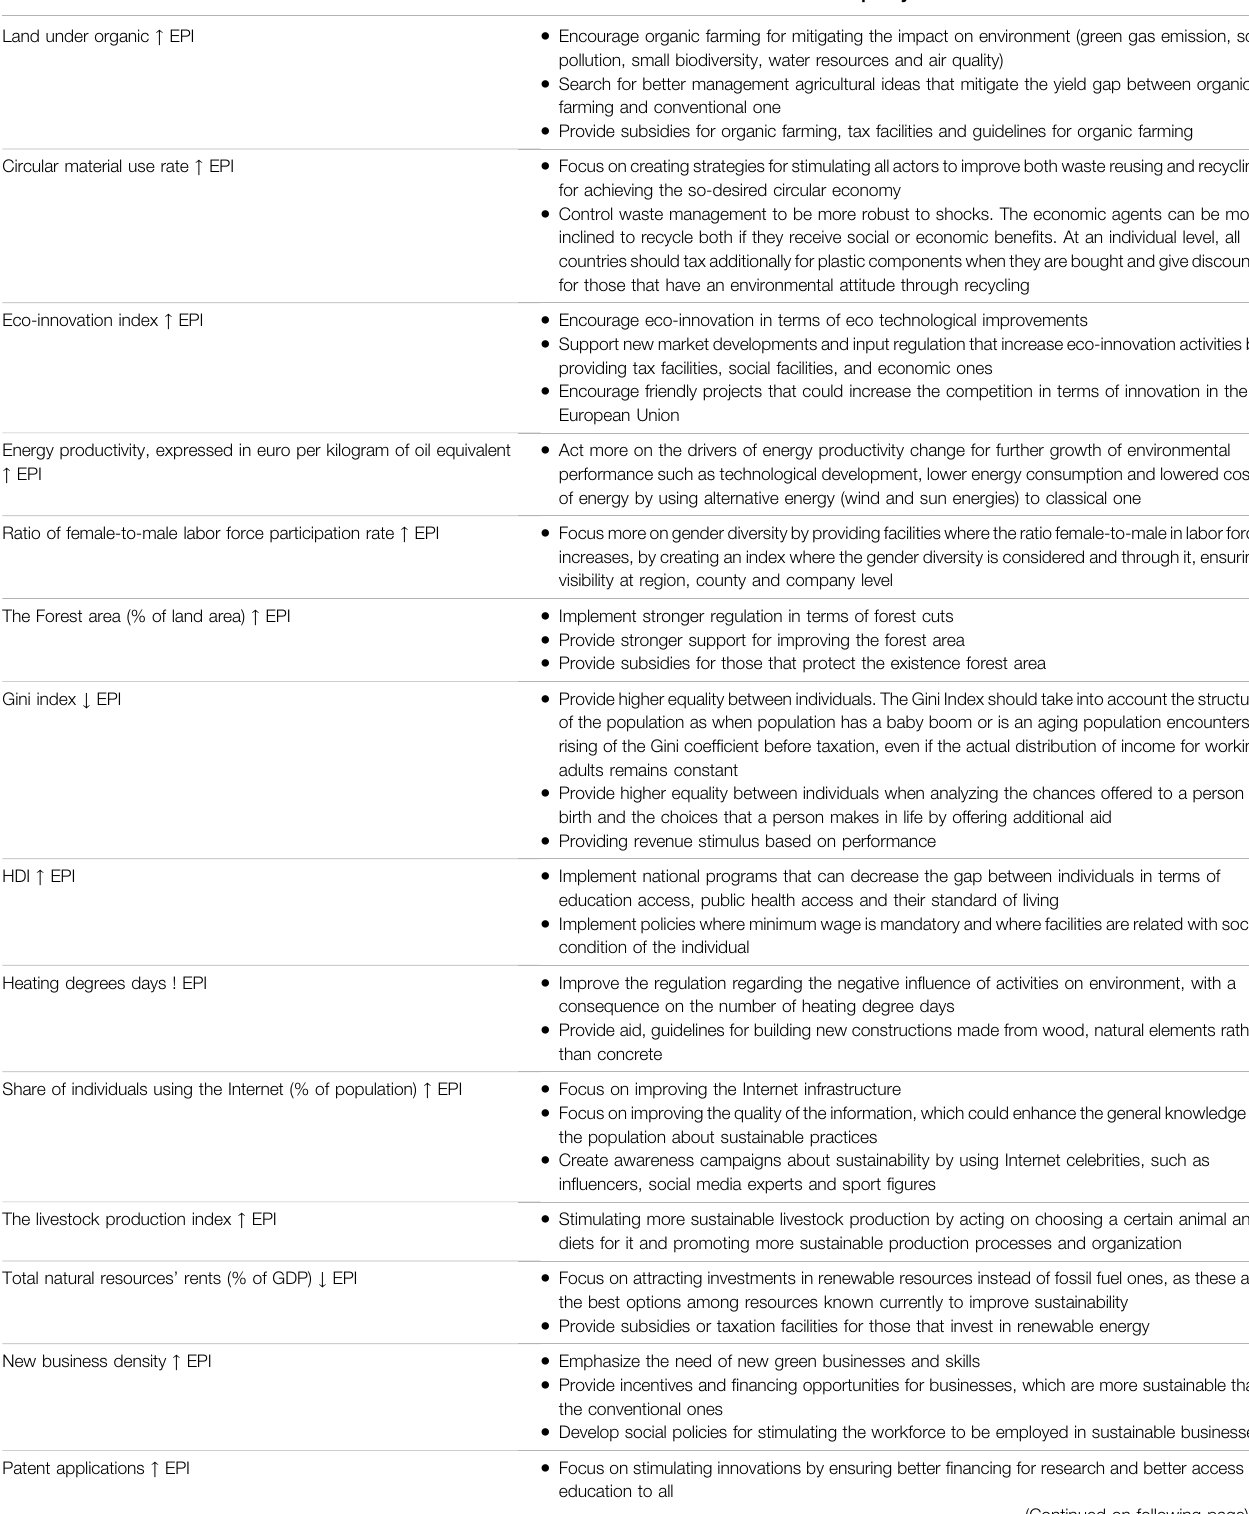
TABLE 5 | In fl uence of variables on EPI and policy recommendations. Factor and in fl uence on